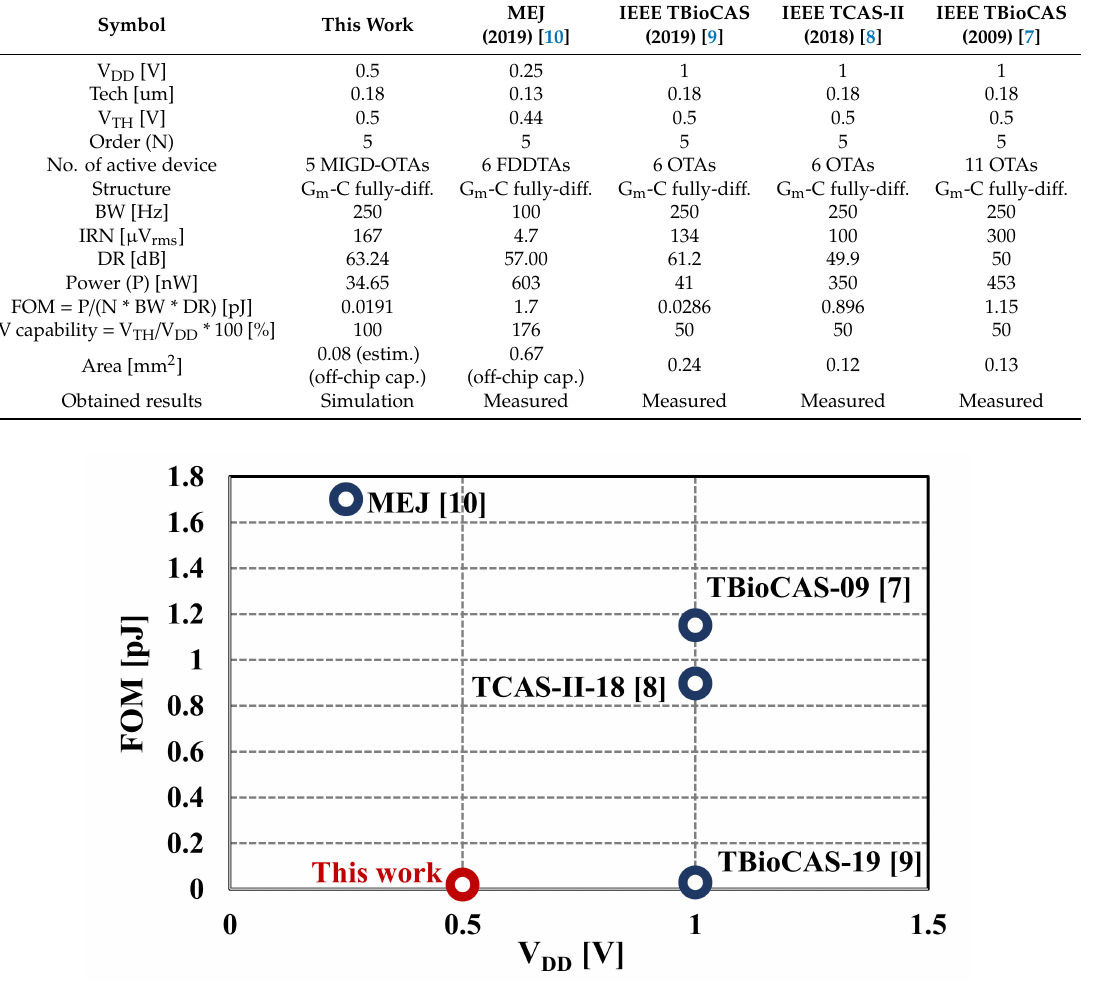
Figure 19. Figure-of-merit (FOM) against V DD of the fifth-order low-pass